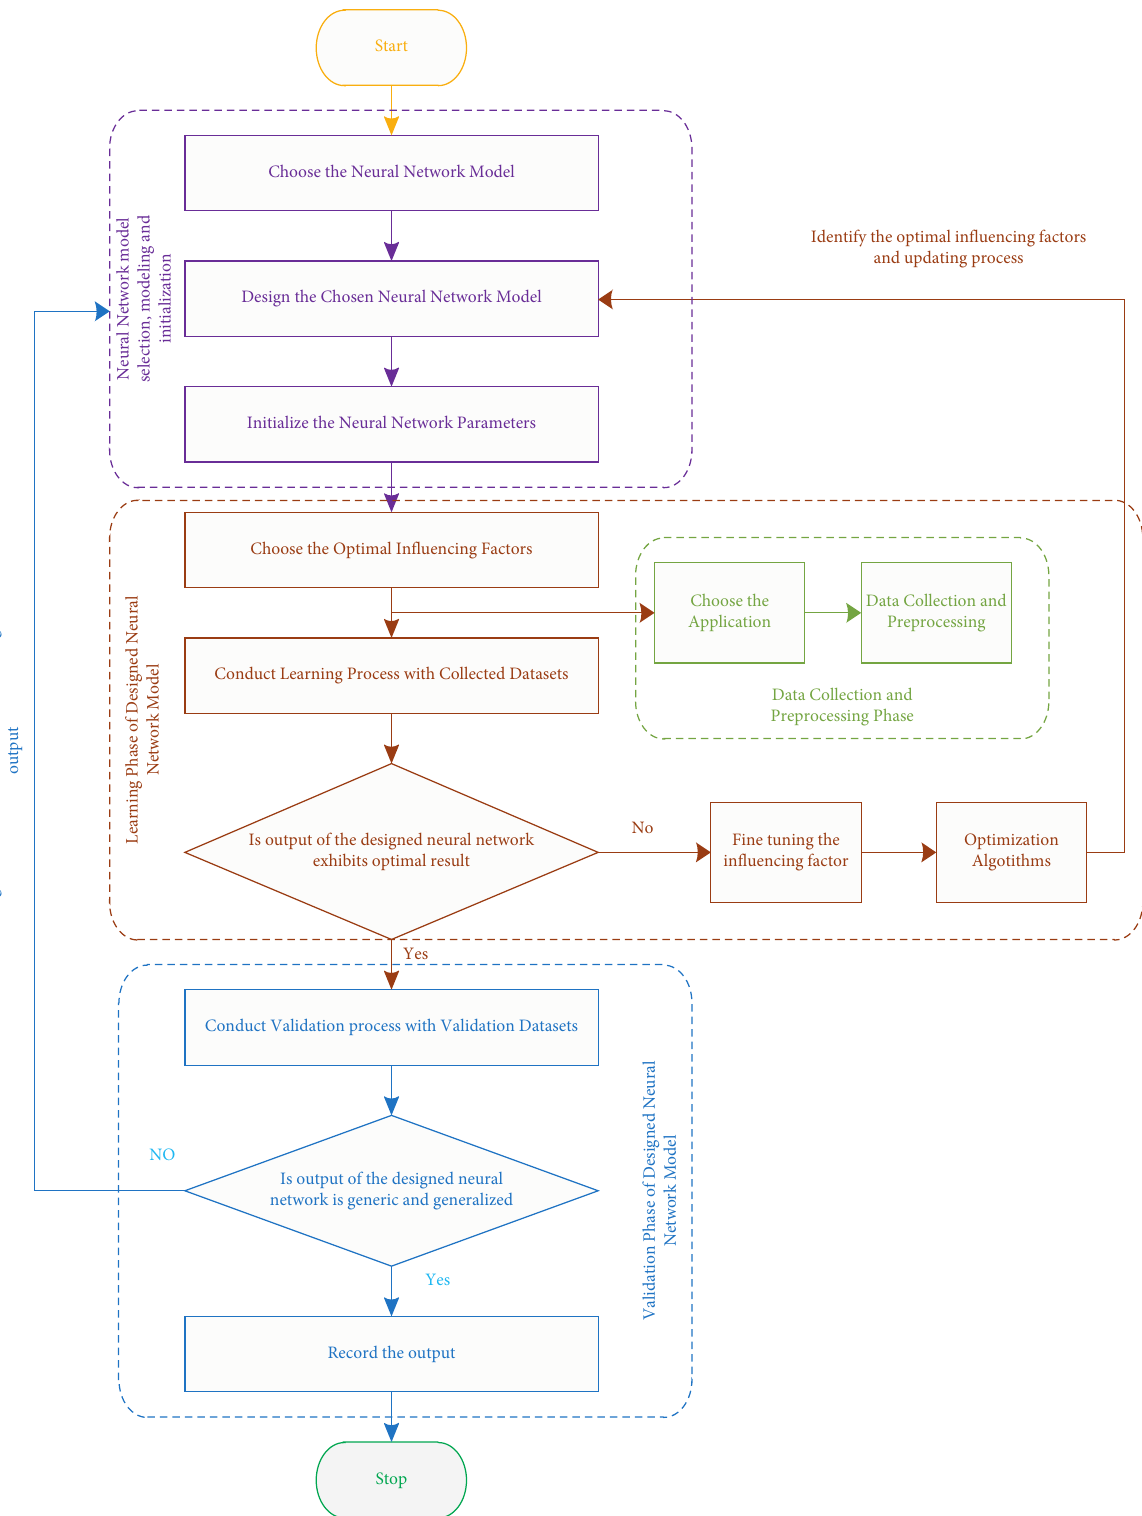
Figure 1: Generalized algorithm of artificial neural